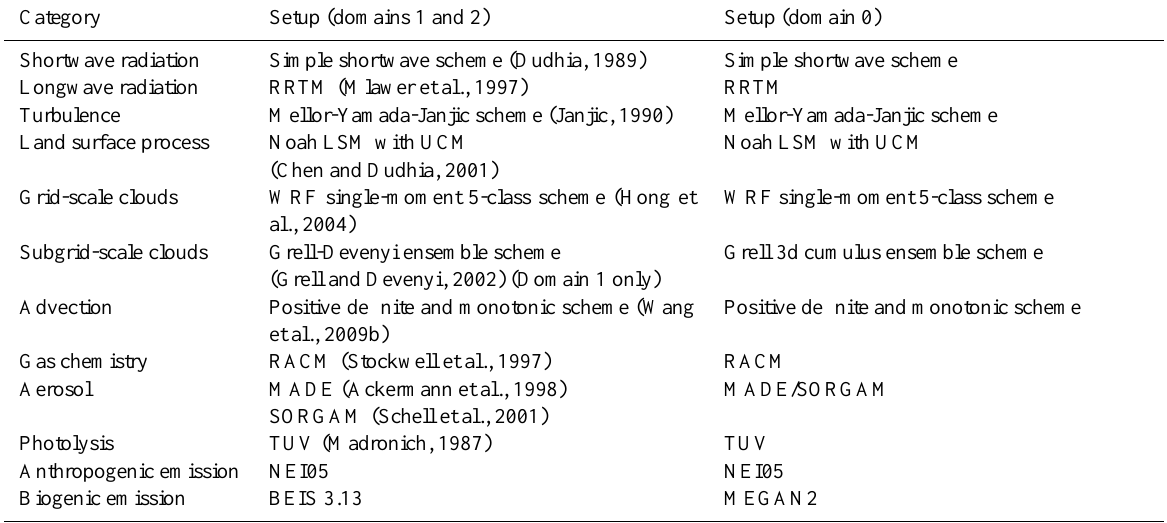
MADE (Ackermann et al., 1998)